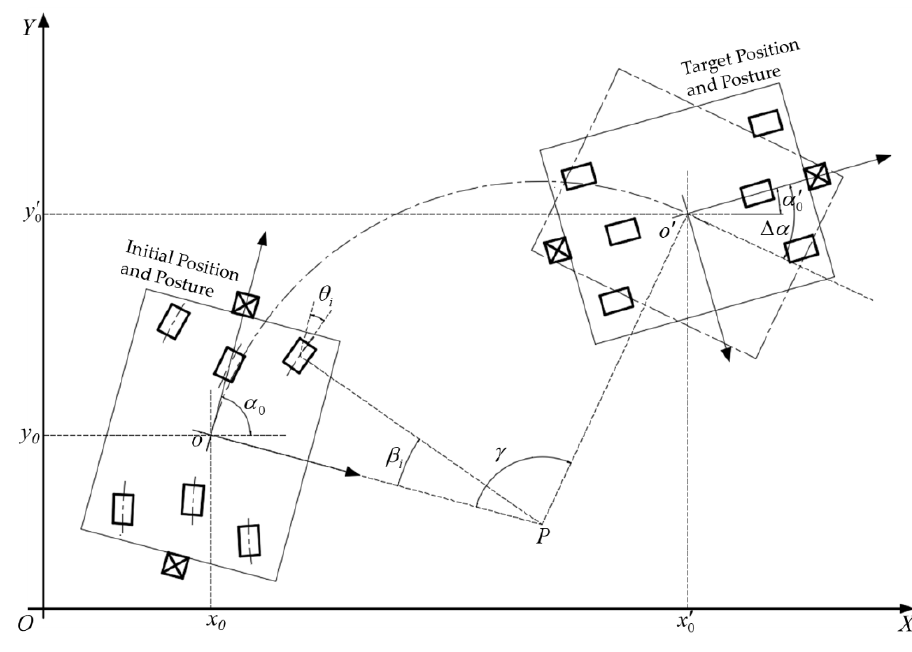
Figure 7. Navigation process in fixed-axis rotation mode.